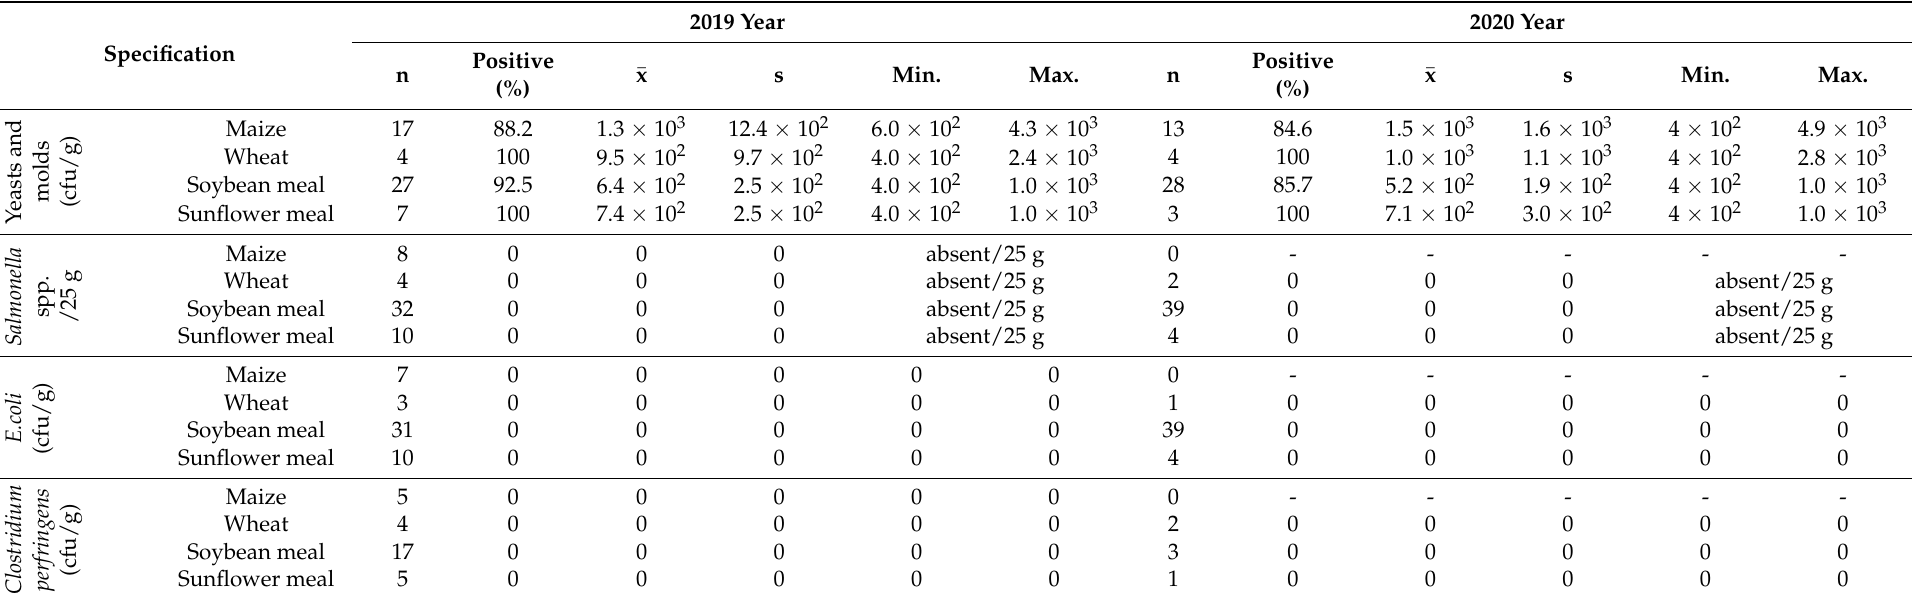
Table 1. Results of microbiological assessment of raw